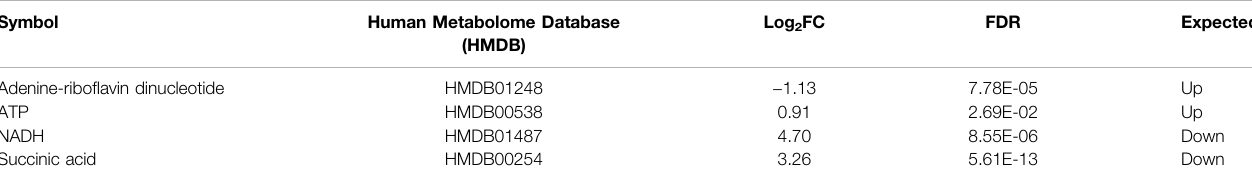
TABLE 2 | List of the four altered metabolites involved in the OXPHOS pathway in MitoPPX cells compared to Wt, identi fi ed by IPA software. Metabolites which were signi fi cantly different (log 2 FC < 0 means decreased expression and log 2 FC > 0 means increased expression) in MitoPPX cells compared to Wt. Alterations in these metabolitesallowedtheIPAsoftwaretopredictadecreaseintheOXPHOSsystem.The ‘ Expected ’ columnindicatesthestatethatproteinispredictedtobeinifthepathway were activated. FDR: False Discovery